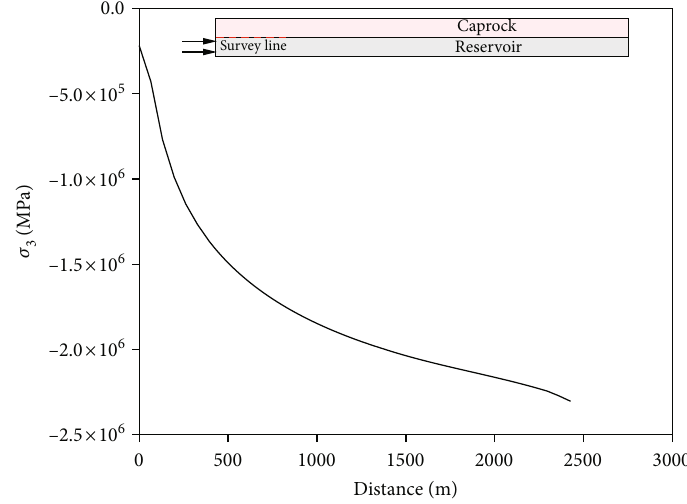
Figure 30: The minimum principal compressive stress of the reservoir-caprock